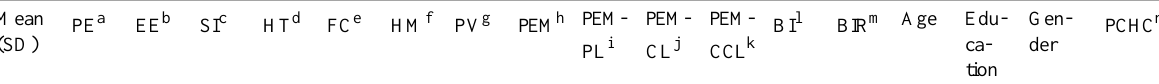
Table 4. Total sample descriptive statistics, correlations, and square root of average variance